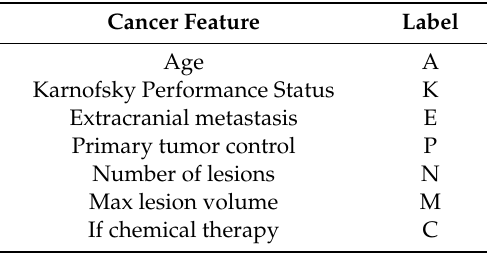
Table 1. The description (letter representation, name) of cancer features in